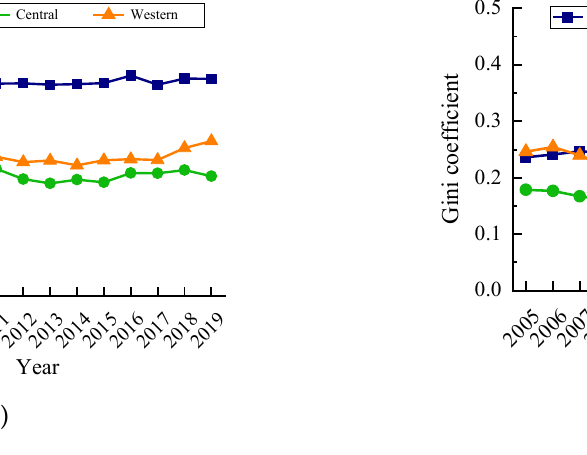
Figure 3. Intra-regional Gini coefficient of carbon emissions of urban production energy consumption from 2005 to 2019. ( a ) Carbon emission quantity. ( b ) Carbon emission intensity. (3) Inter-regional differences